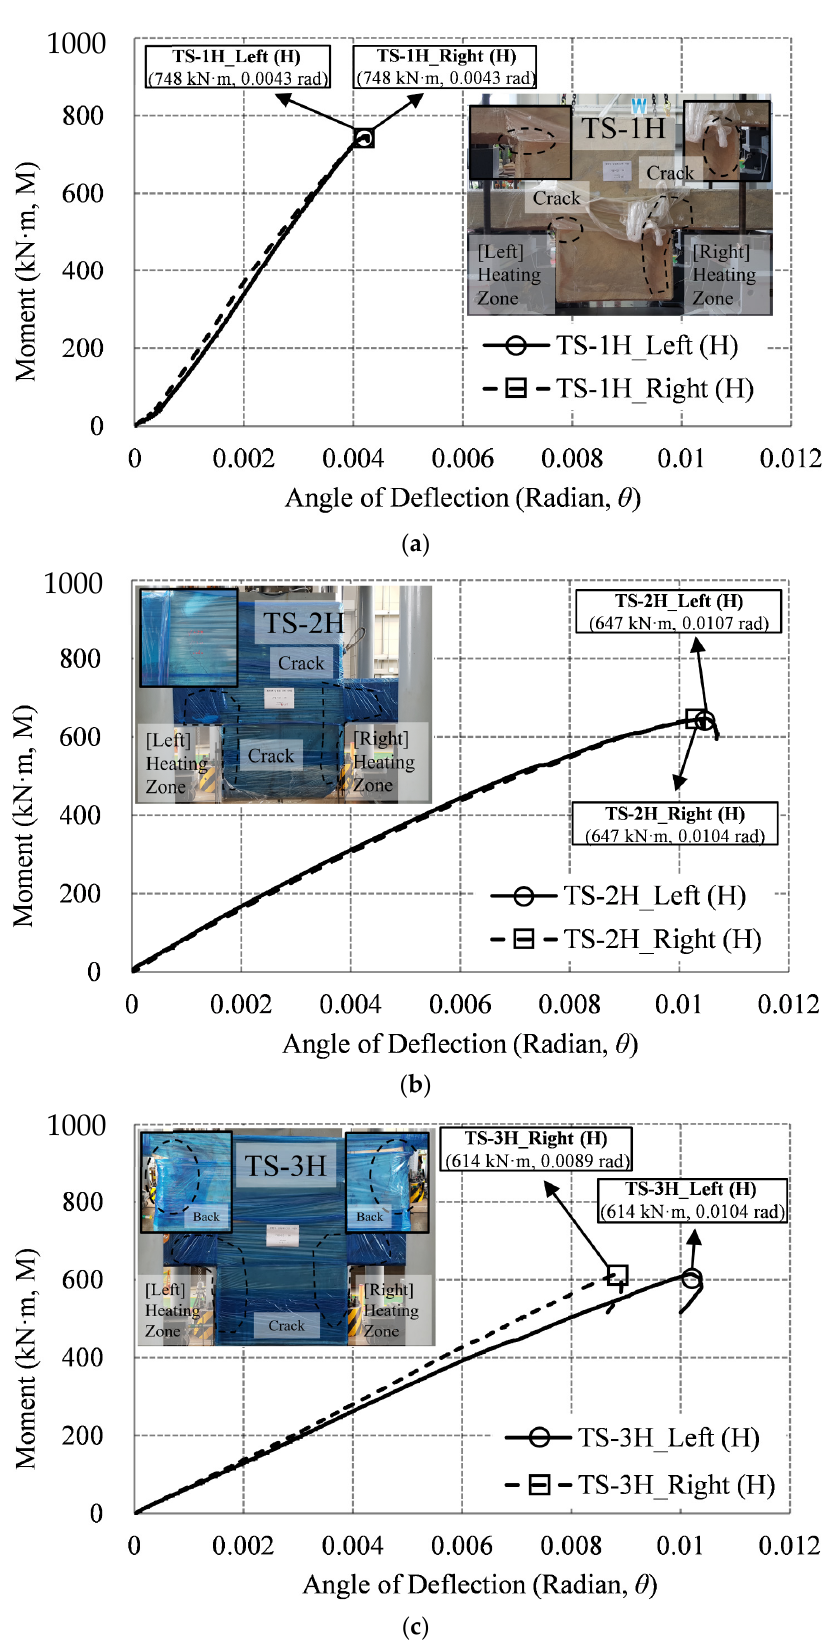
Figure 18. Moment–deflection angle relationship (TS specimen): ( a ) 1 h (TS-1H); ( b ) 2 h (TS-2H); ( c ) 3 h (TS-3H).